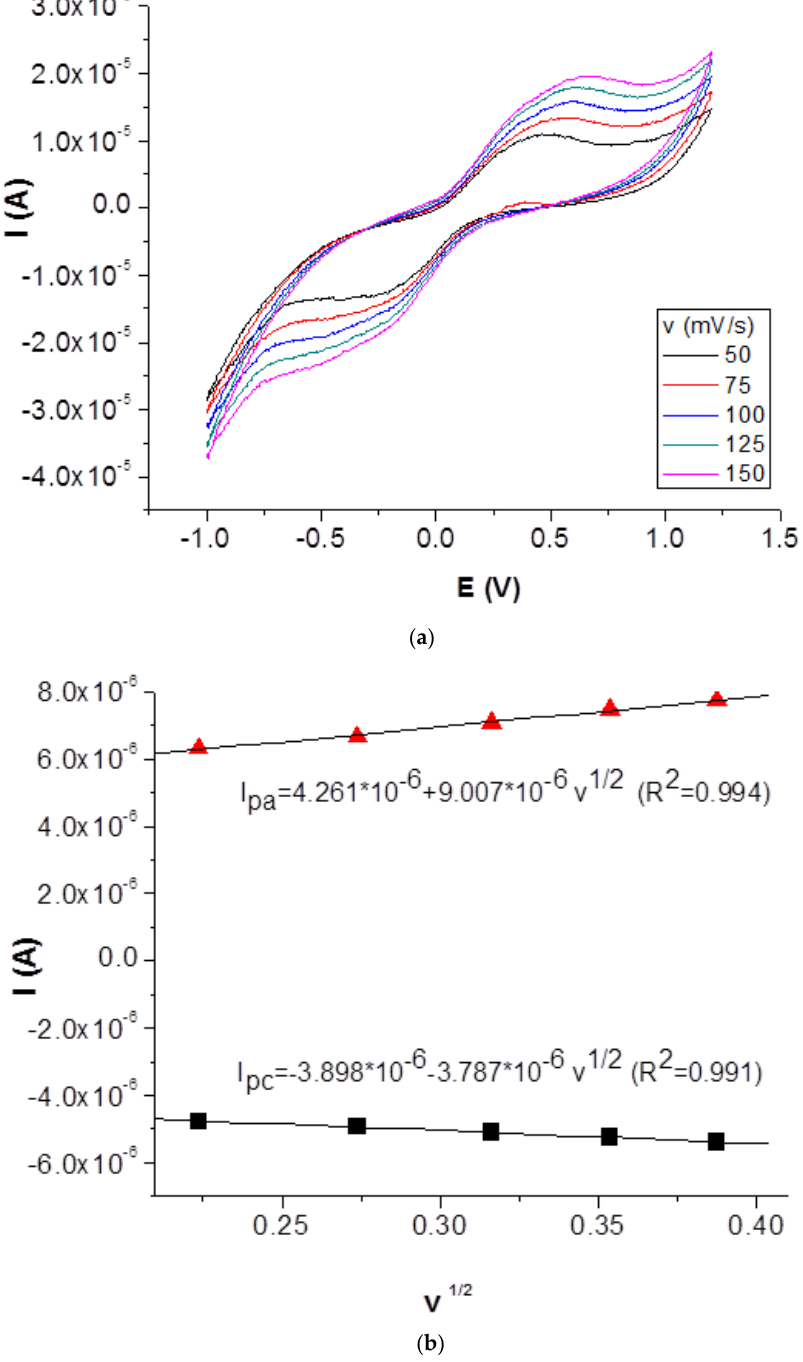
Figure 4. ( a ) Cyclic voltammograms for 1.0 mM K 3 [Fe(CN) 6 ] in 0.1 M KCl solution on TC2 modified carbon paste electrode, v = 50–150 mV s − 1 ) and ( b ) I vs. v½ plot. The same experiments were performed for all modified electrodes. A comparison of